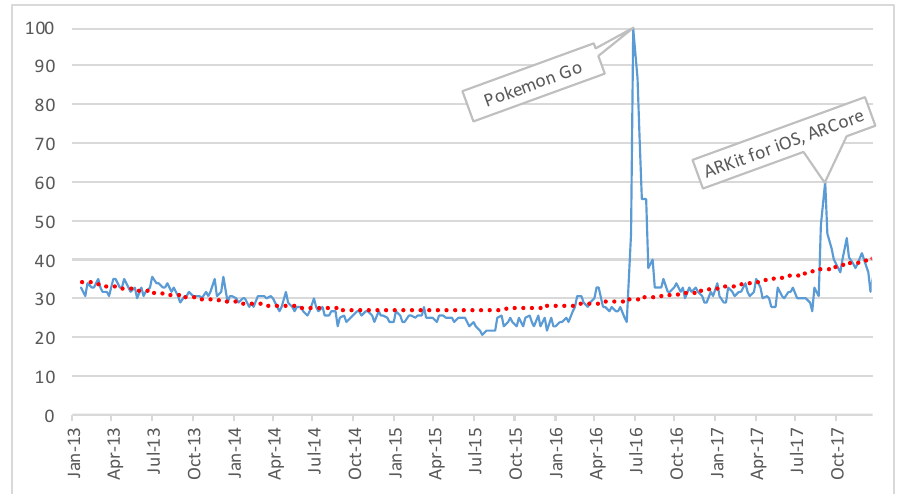
Figure 9. Google Search Trends of Augmented Reality apps (Source: Google Trends). Data has been normalized to the day with highest number of searches (around Pokemon Go release date).